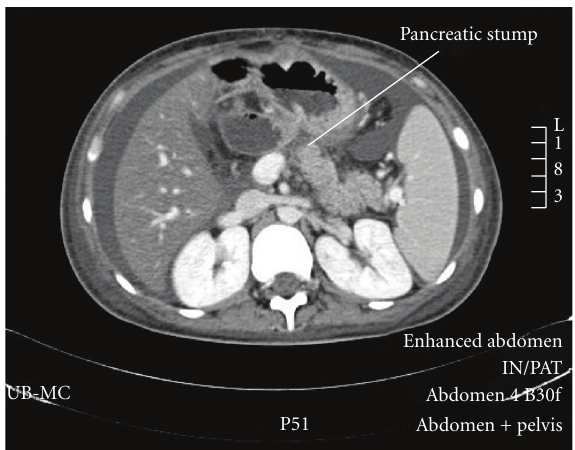
Figure 1: Abdominal CT scan showing the disconnected pancreatic stump with fluid in the